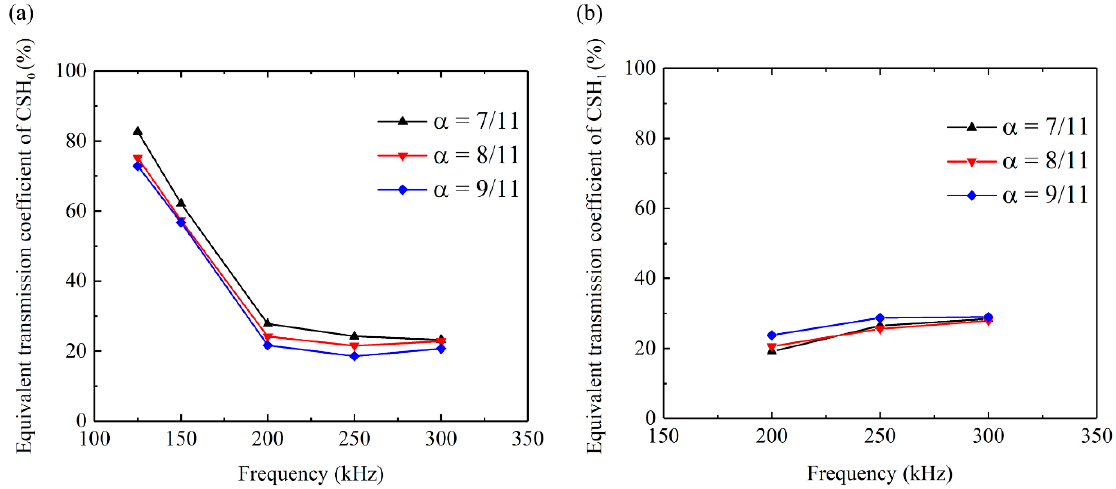
Figure 14. Equivalent transmission coefficients for notches with different depths by sending pure ( a ) CSH 0 and ( b ) CSH 1 wave at different frequencies.